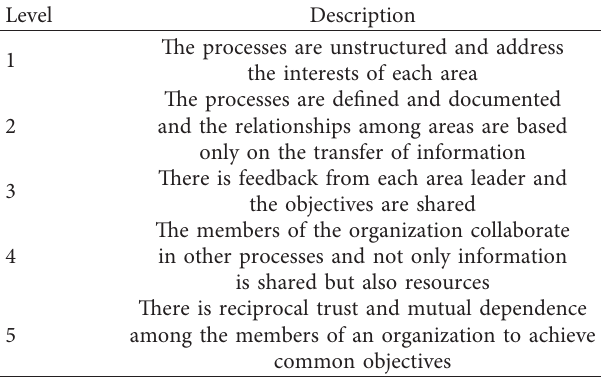
Table 4: Maturity level of a company